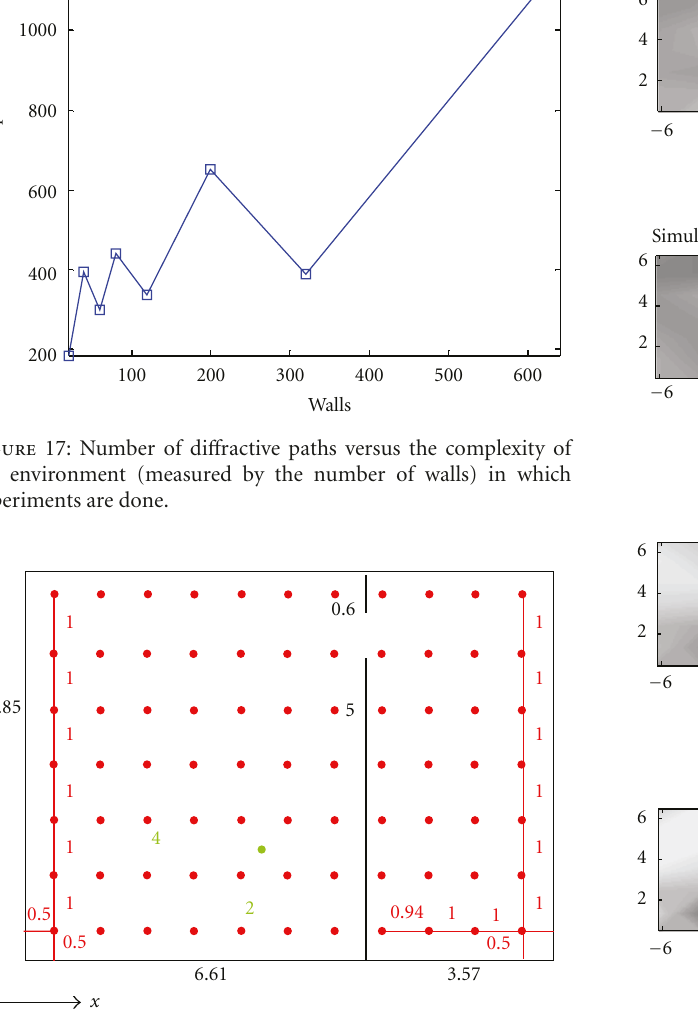
Figure 19: Early Decay Time map: (a) simulated with reflections only, (b) simulated with reflections and di ff raction, (c) simulated with reflections, di ff raction and di ff usion, (d)